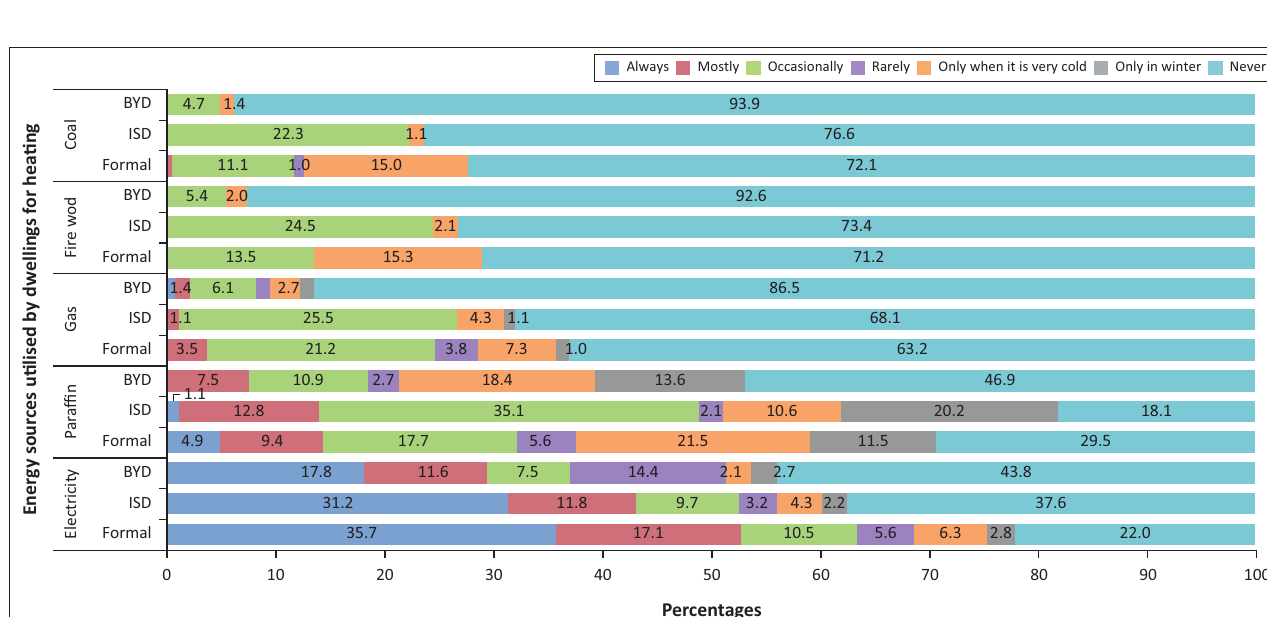
FIGURE 8: Energy sources used for boiling water by households.